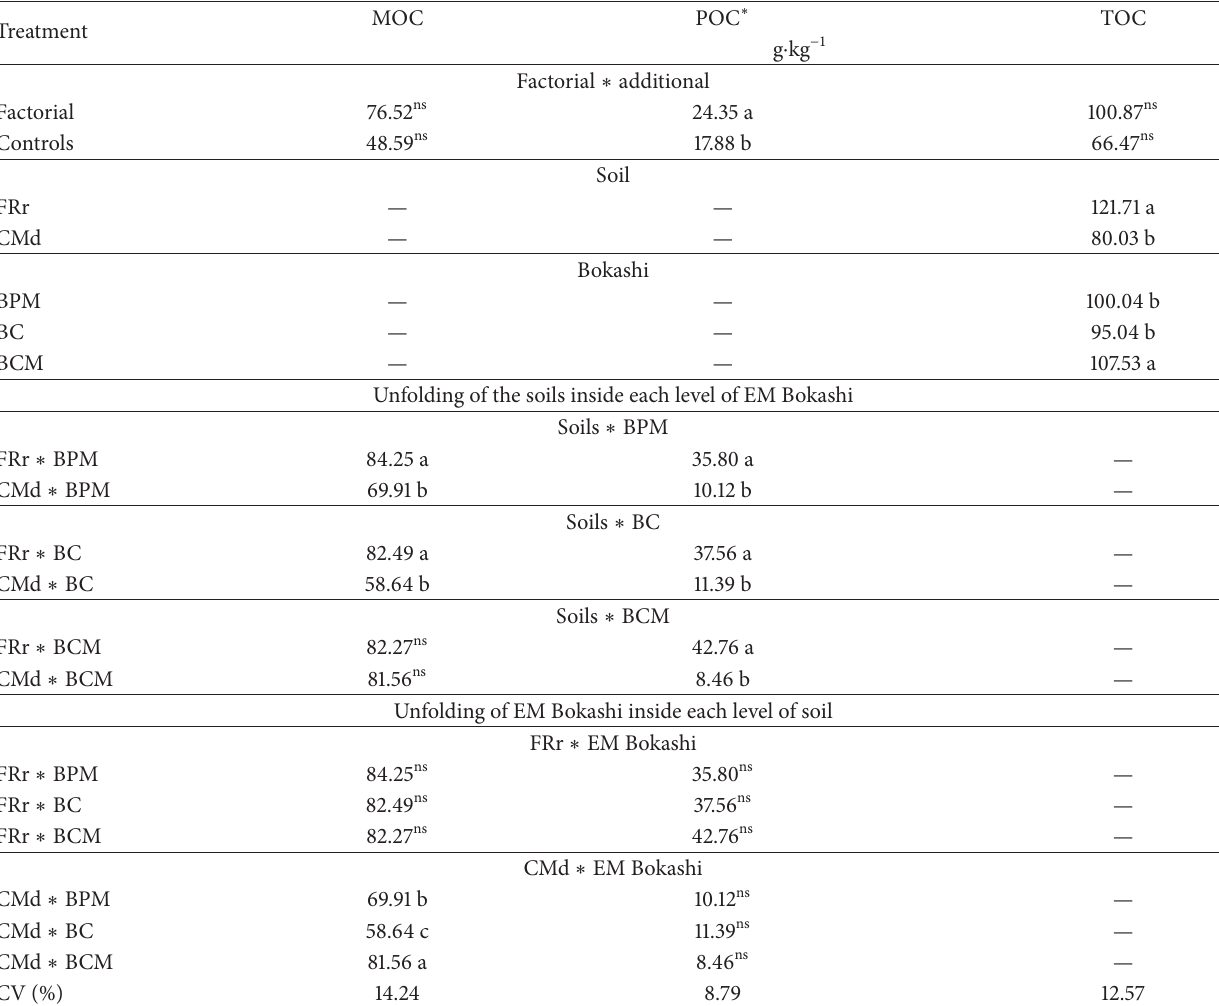
Table 4: Means of MOC, POC, and TOC evaluated in FRr and CMd fertilized with Bokashi and cultivated with tomato.